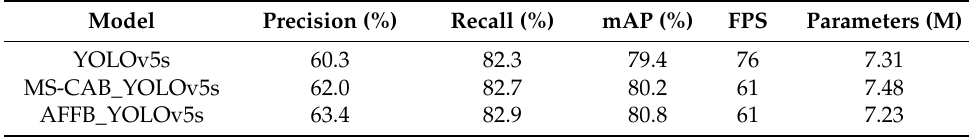
Table 4. Performance comparison of models on PASCAL VOC test